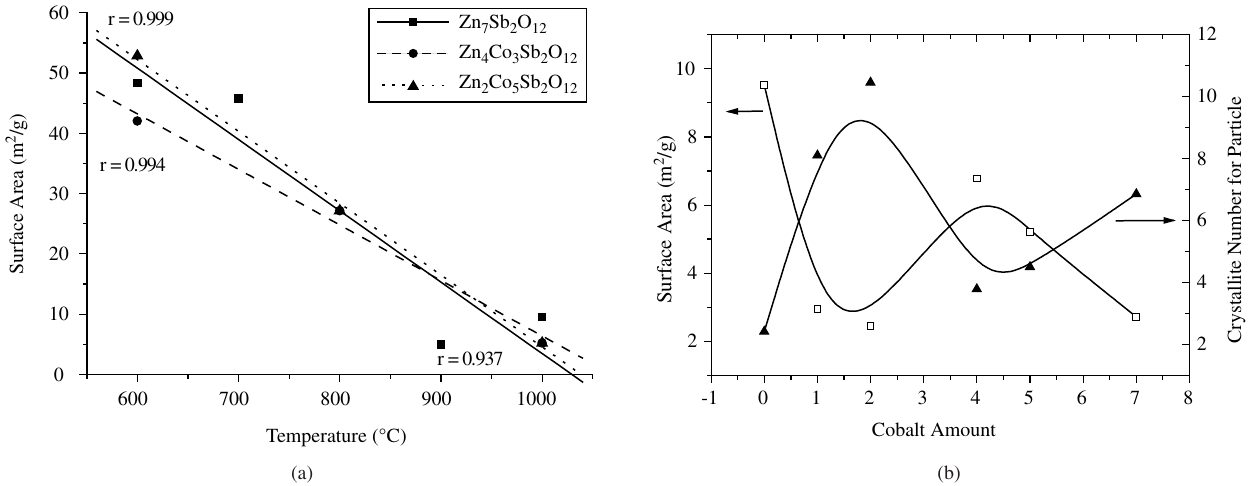
Figure 9. Surface area results: a) Variation as a function of temperature; b) Variation as a function of cobalt amount.